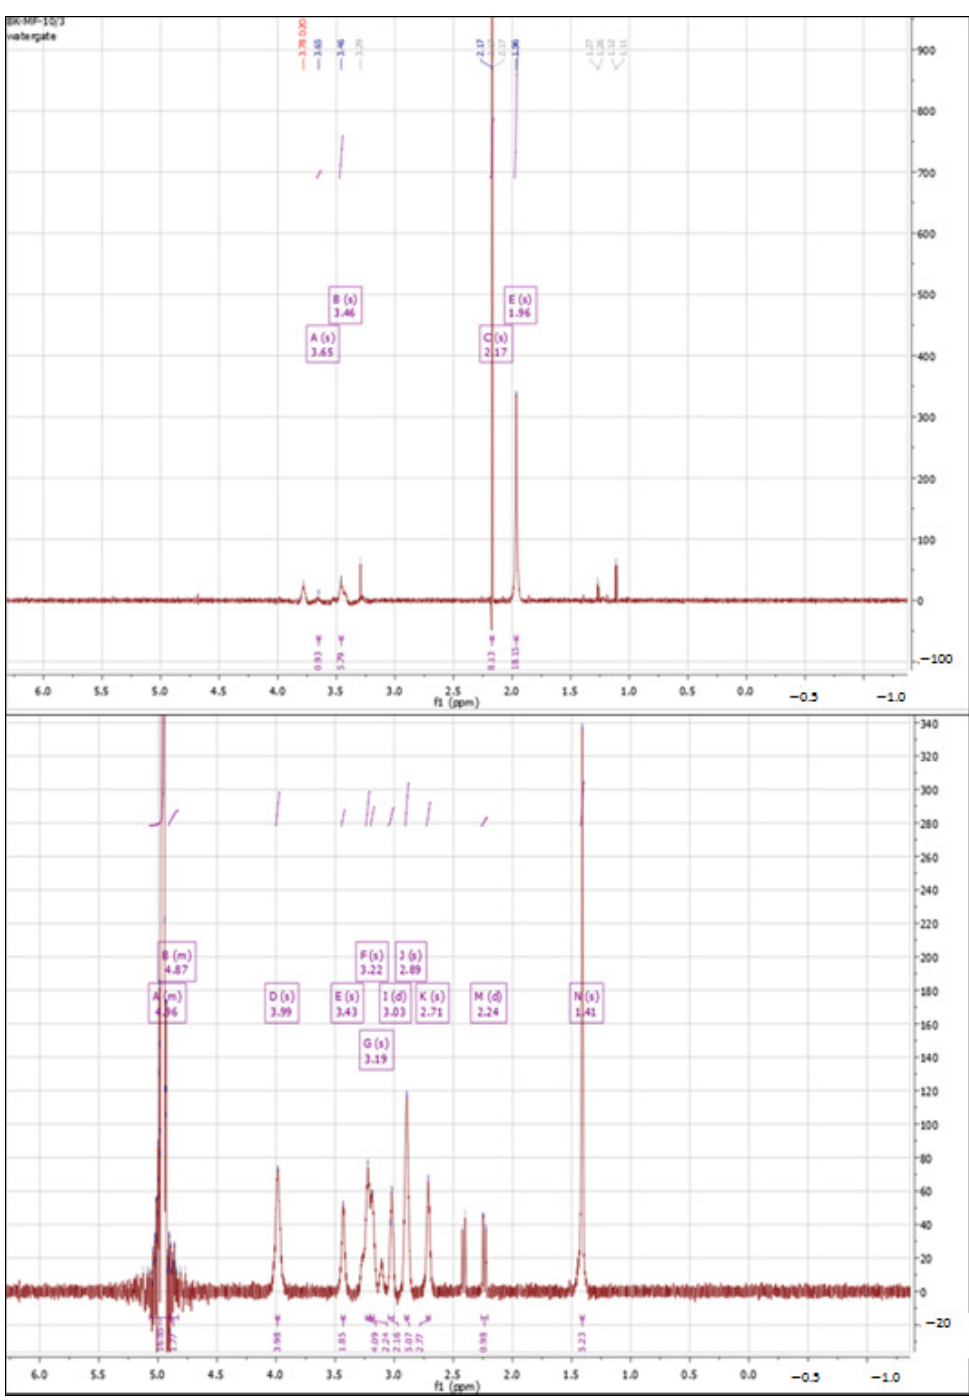
Figure 4. 1 H NMR spectra of native HA ( top ) vs. HA cross-linked with 5% citric acid via Procedure II ( bo tt om ).